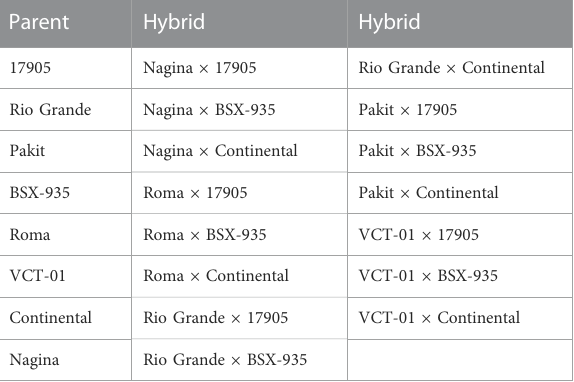
TABLE 1 List of parents and hybrids used in the